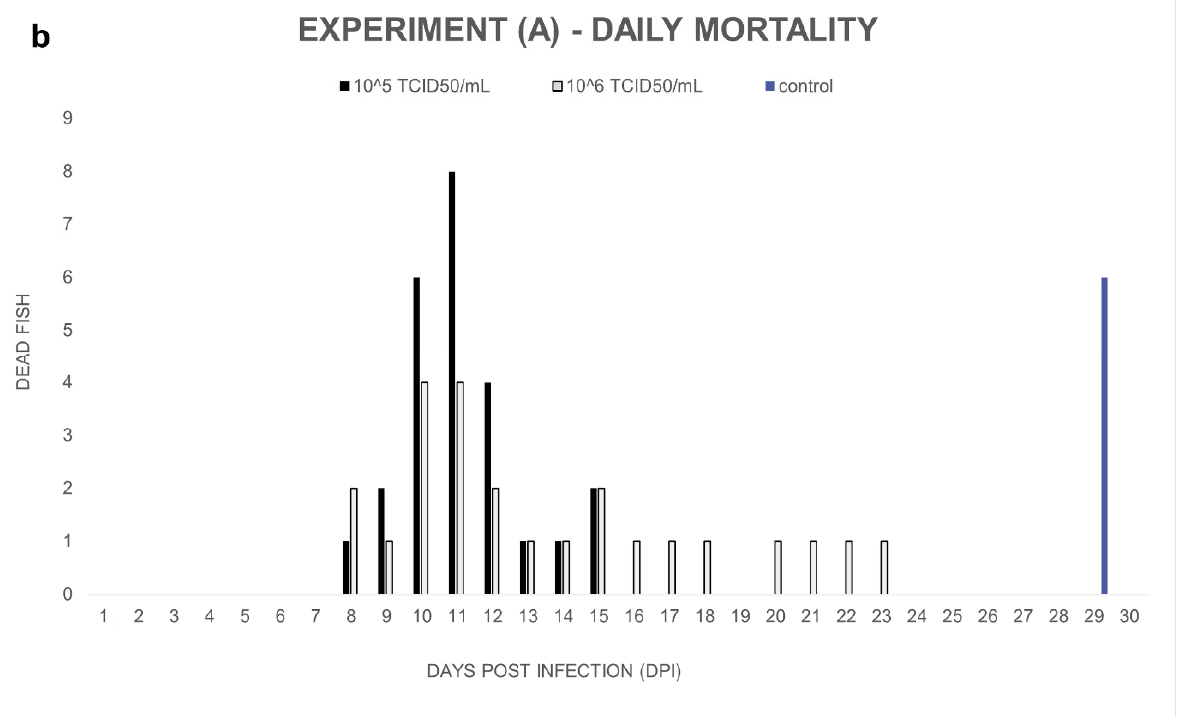
Figure 1. ( a ) Cumulative mortality in Exp. (A), wels catfish ( Silurus glanis ) ( n = 25/group) were in- fected at 8 weeks of age by bath with ECV at 21 ± 0.5 °C for 1 h. Mortality was recorded from 0 to 30 dpi, including the control group. The number of the control group was reduced due to cannibalism. ( b ) Daily mortality in Exp. (A) shows the number of dead fish per day.